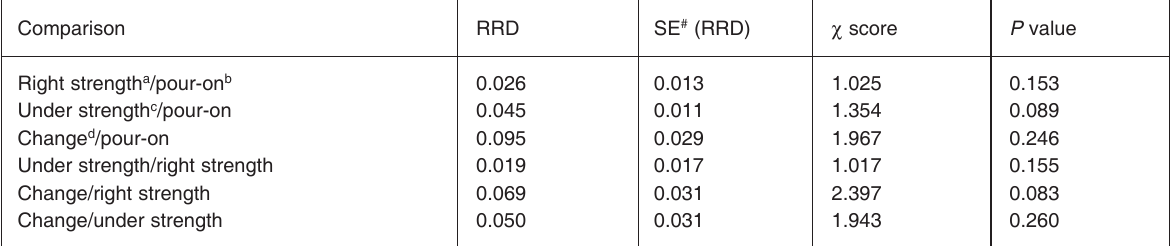
TABLE 2 East Coast fever-related calf mortality risk-rate differences (RRD), pair-wise comparison for the different tick control prac- tices strata